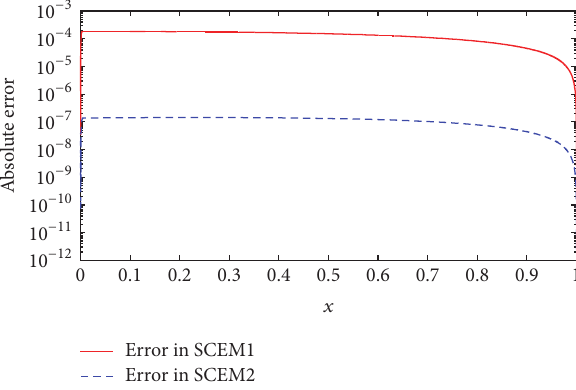
Figure 2: Delay effect on left layer problem for 𝜀 = 0.01 , 𝛿 = 0.01𝜀 , and 𝛿 = 0.9𝜀 .